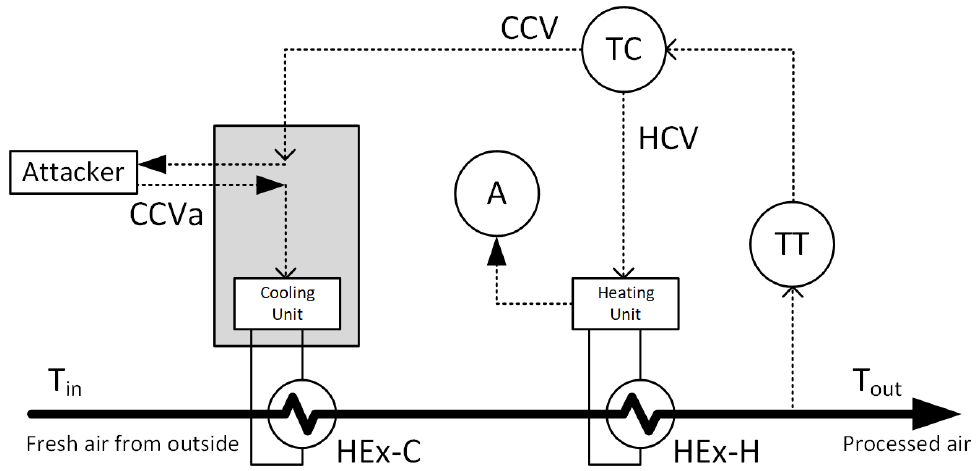
Figure 1. Feedback control of the air conditioning unit.